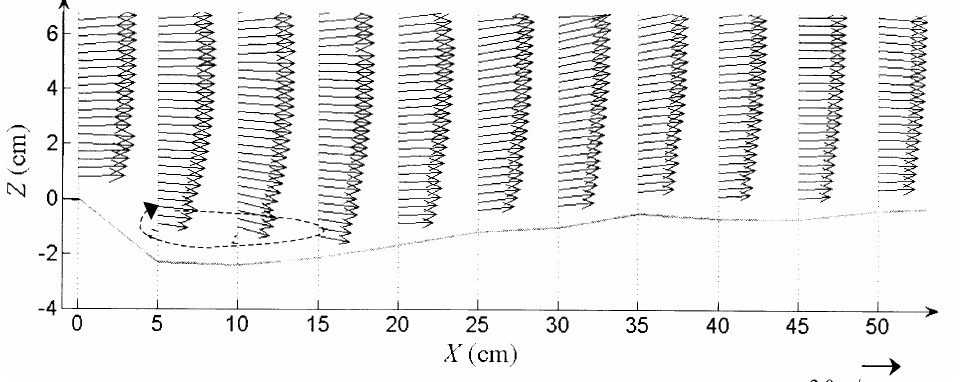
Fig. 4 Vertical distributions of U l , NV run